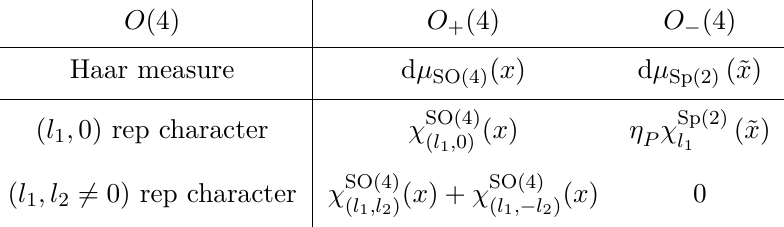
Table 2 . Haar measure and characters for O (4) in terms of those of the classical Lie groups. A general unitary SO(4) irreducible rep (irrep) is labelled by its highest weight l = ( l 1 , l 2 ) ,